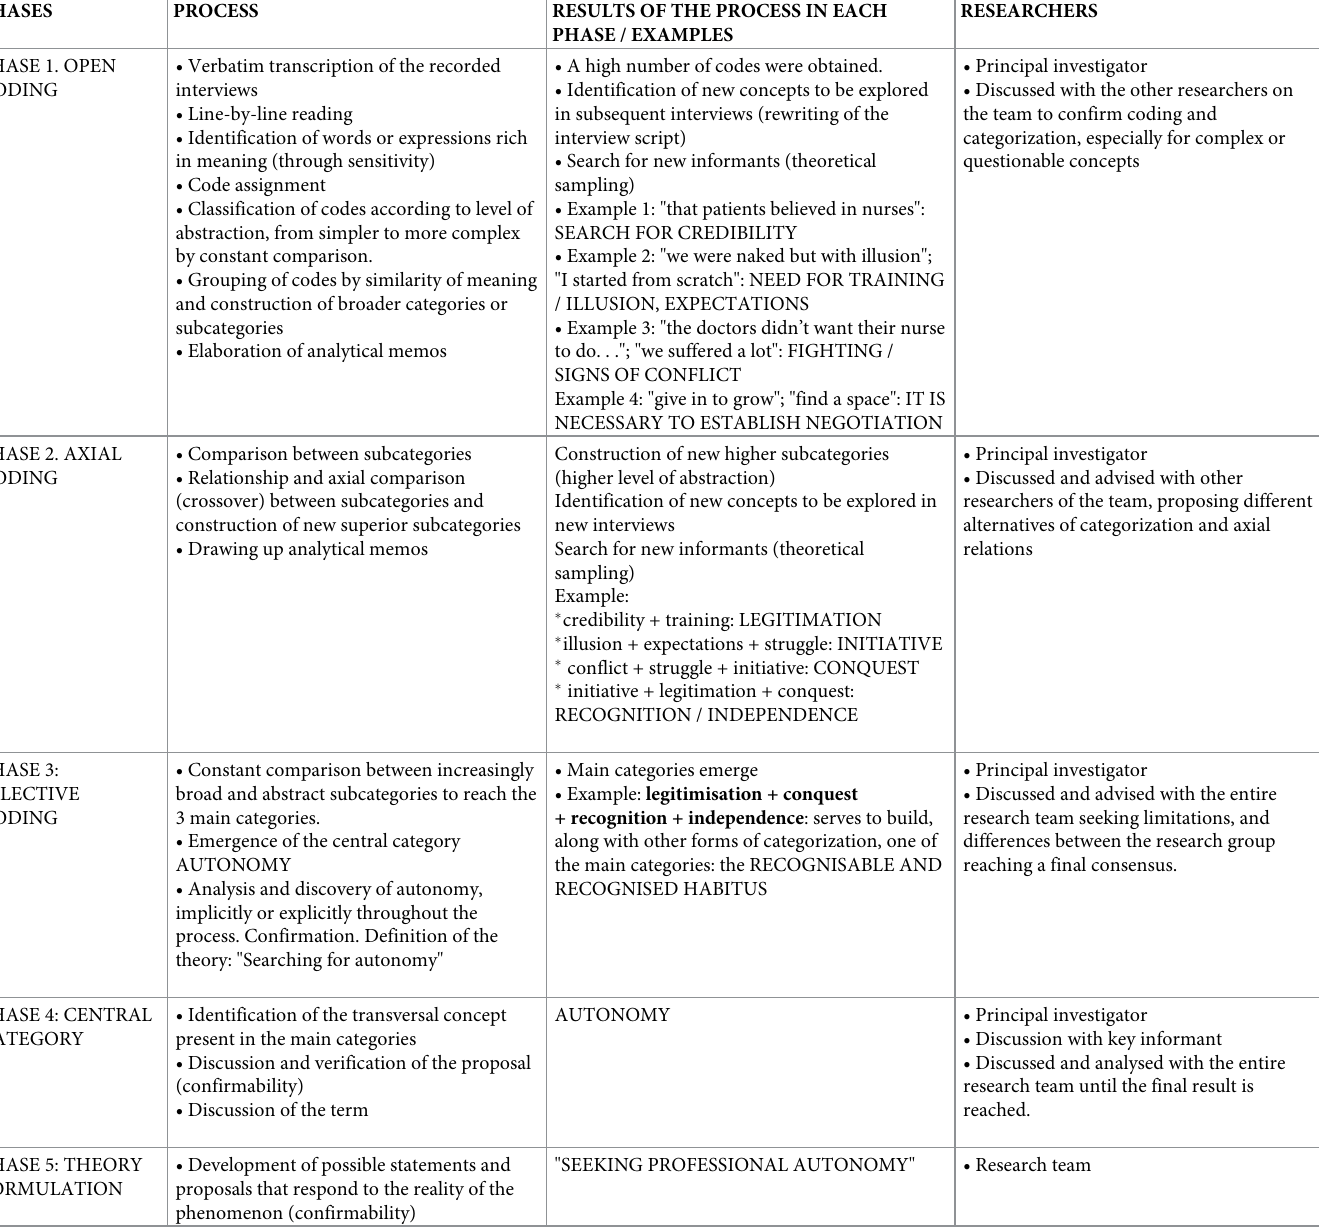
Table 2. Process of analysis, codification and categorisation. Central